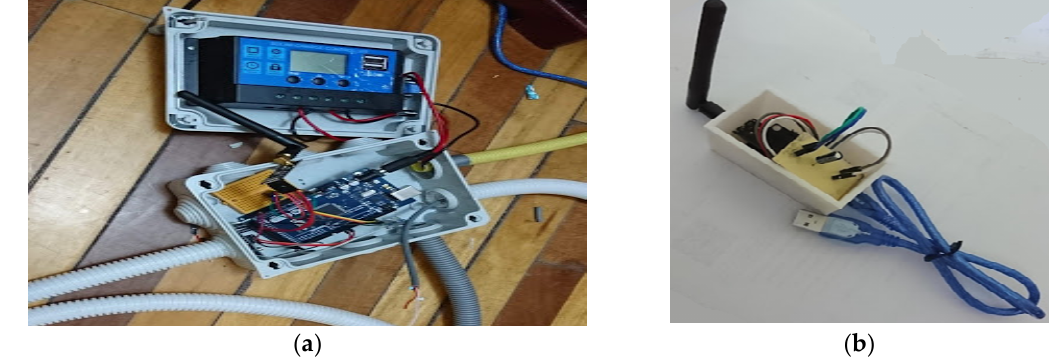
Figure 11. Implementation of Nodes: ( a ) Sensor Node. ( b ) Gateway Node.